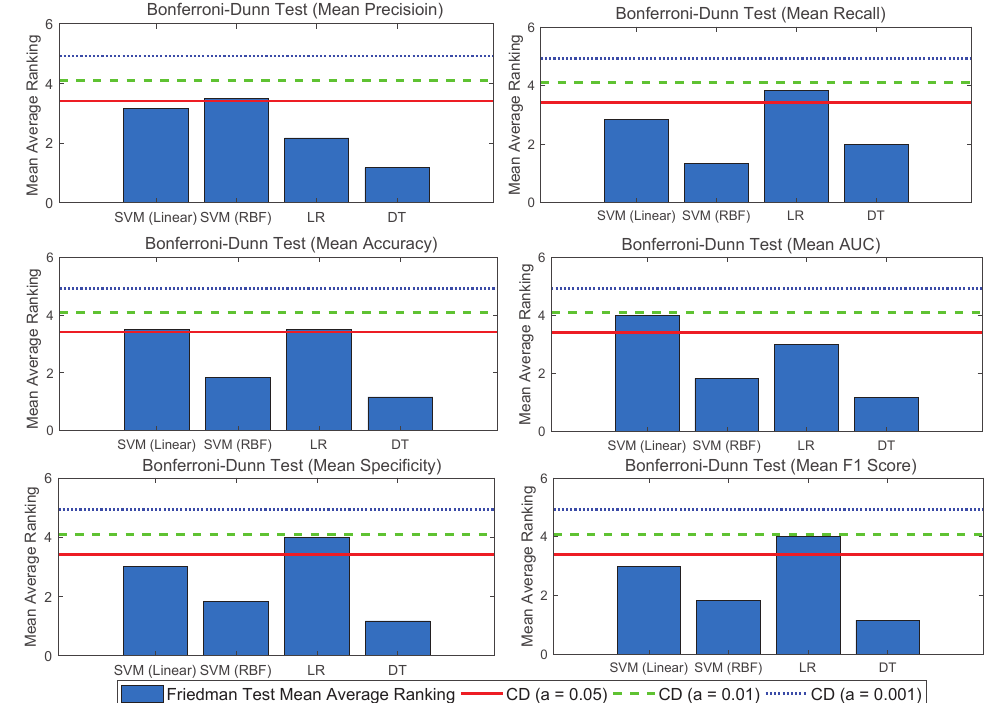
Figure 6. Result ranked with Friedman test and Bonferroni–Dunn test of four ML algorithms (SVM (Linear kernel), SVM (RBF kernel), LR, and DT ) with precision, recall, accuracy, AUC, Specificity, and F1 Score in significant levels of α < 0.05, α < 0.01, and α < 0.001 taking DT as a control algorithm in Figure 4 results.